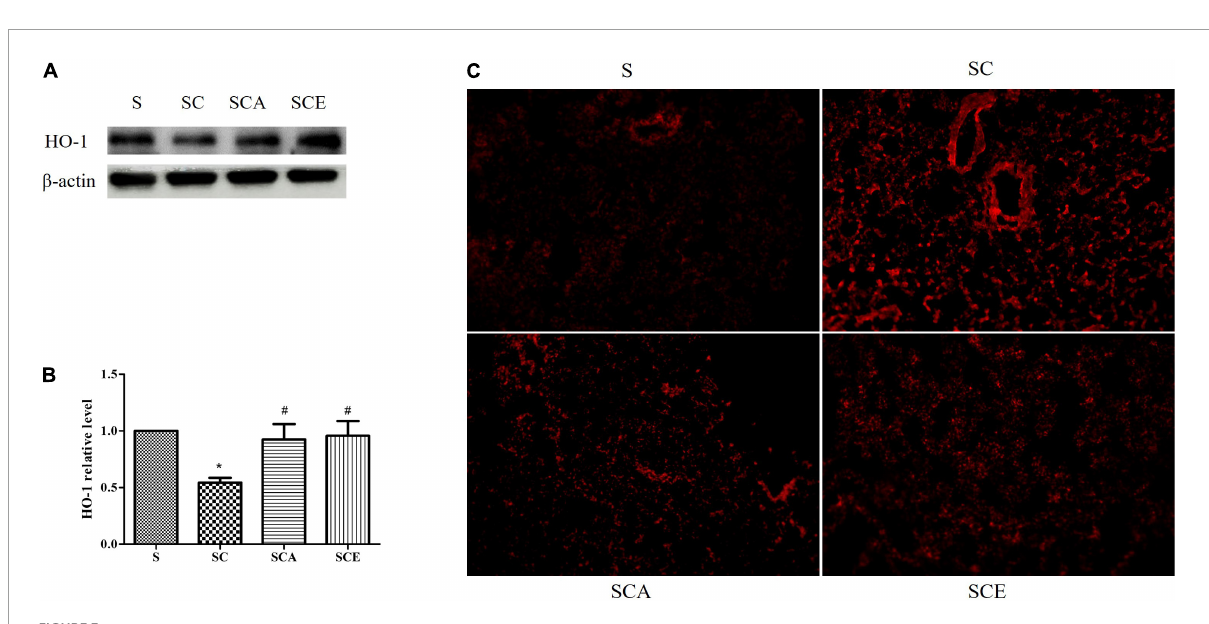
FIGURE3 Effects of atorvastatin and ezetimibe treatment on lung oxidative stress in hypercholesterolemic rats. (A) Western blot bands of heme oxygenase-1 (HO-1) and Beta-actin ( β -actin) expression in lung tissues; (B) quantified levels of lung HO-1 expression; (C) lung dihydroehthidium (DHE)